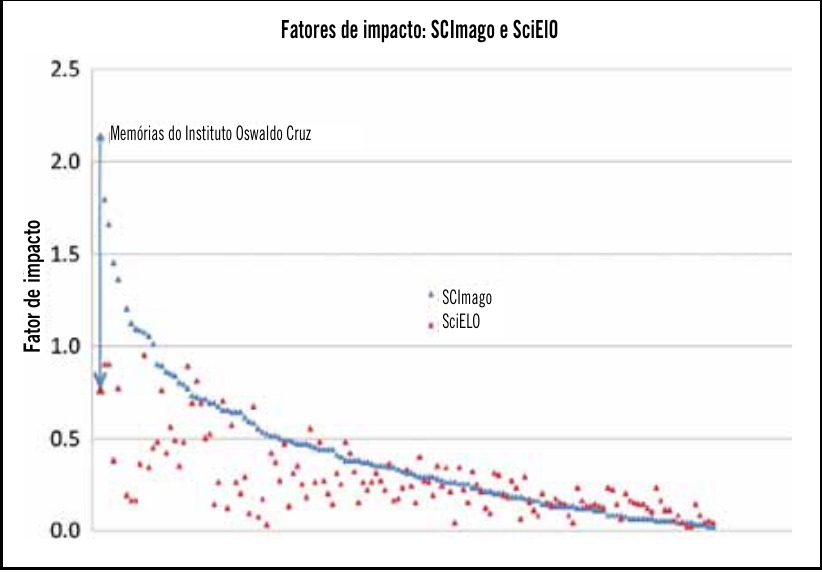
Figura 2 – Fatores de impacto SCImago e SciELO (2009) para 142 periódicos brasileiros representados nos dois índices com valor > 0. Observe-se que quando SCImago > SciELO, a diferença é frequentemente grande (como indicado pela seta vertical relativa às Memórias do Instituto Oswaldo Cruz), mas invariavelmente diminuta quando SciELO > SCImago